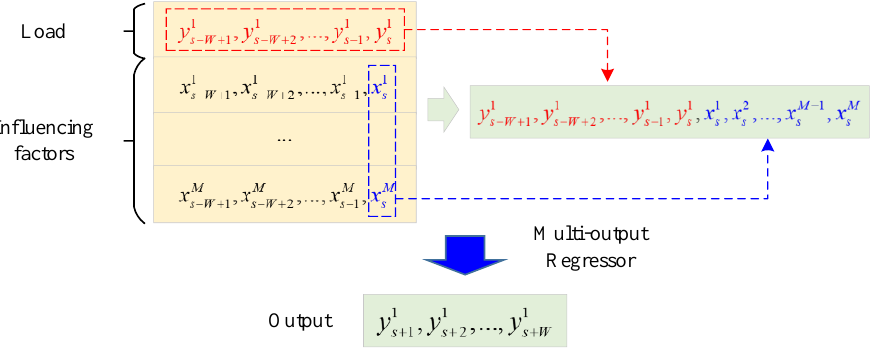
Figure 1. The basic principle of window-based XGBoost model.